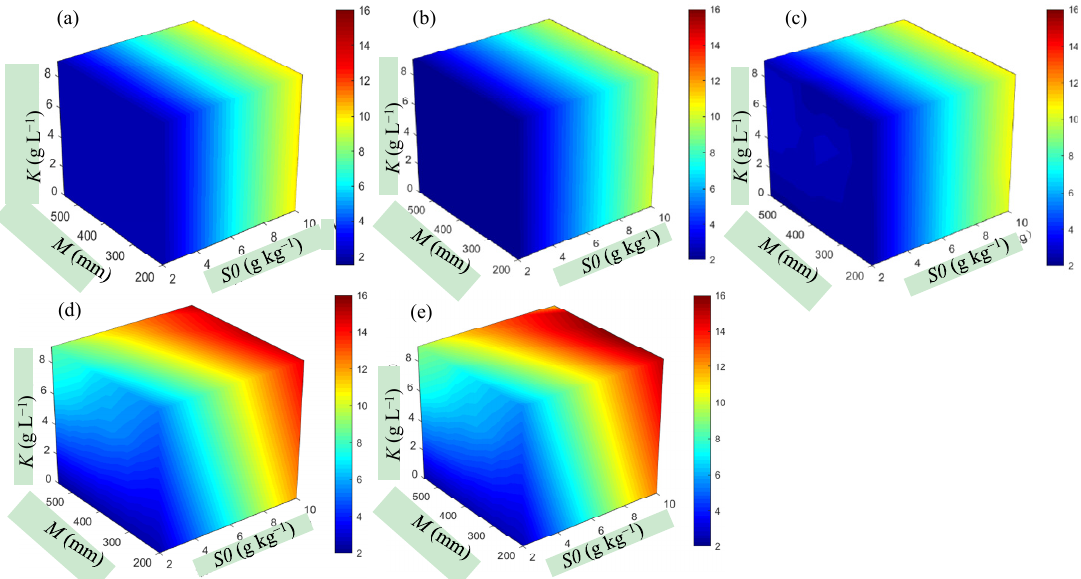
Figure 9. Dynamic thresholds of soil salt content in the root zone at different growth stages when W 0 = 0.85 θ fc : at the beginning of ( a ) the growth stages, ( b ) the bud stage, ( c ) the flowering–boll stage, ( d ) the boll-opening stage, ( e ) at the end of the growth stages.